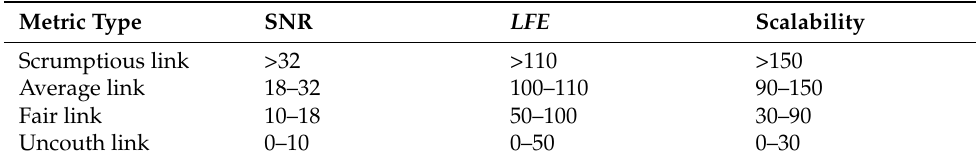
Table 1. LSA link Table 1. LSA link corpus.